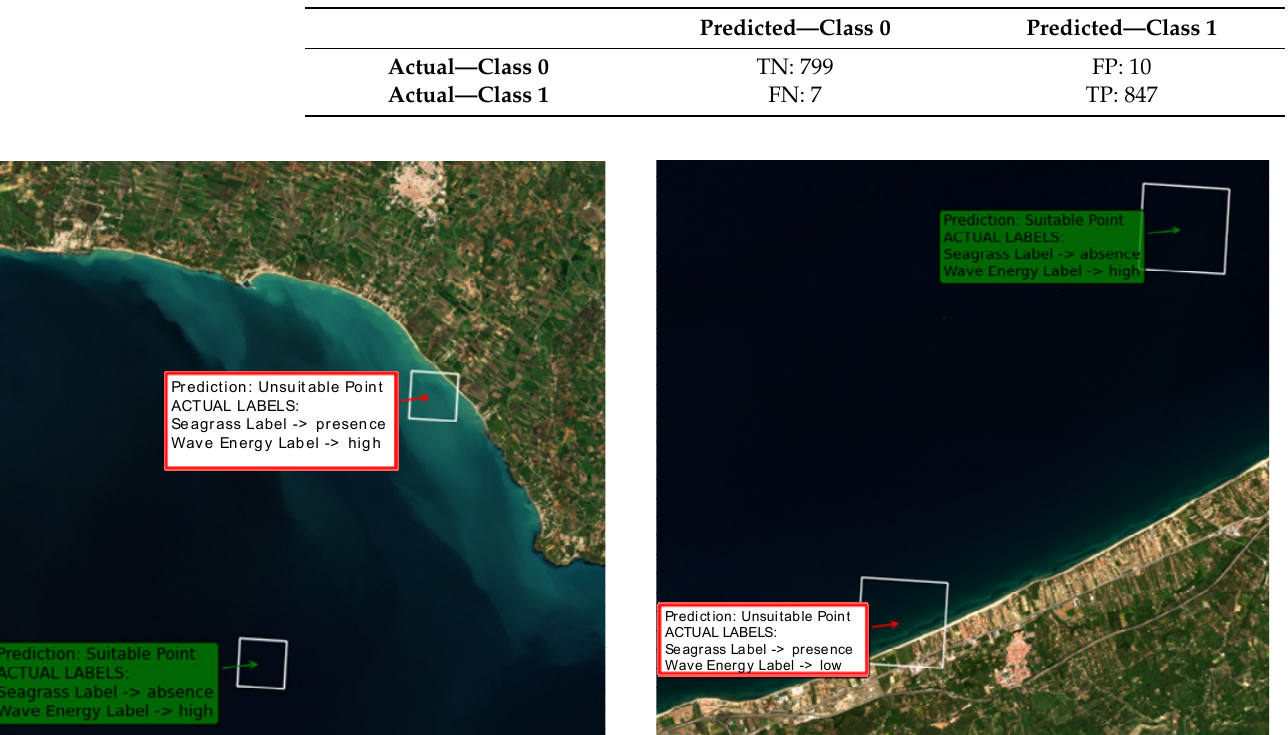
Figure 9. Data Fusion based Neural Network predictions on test dataset.